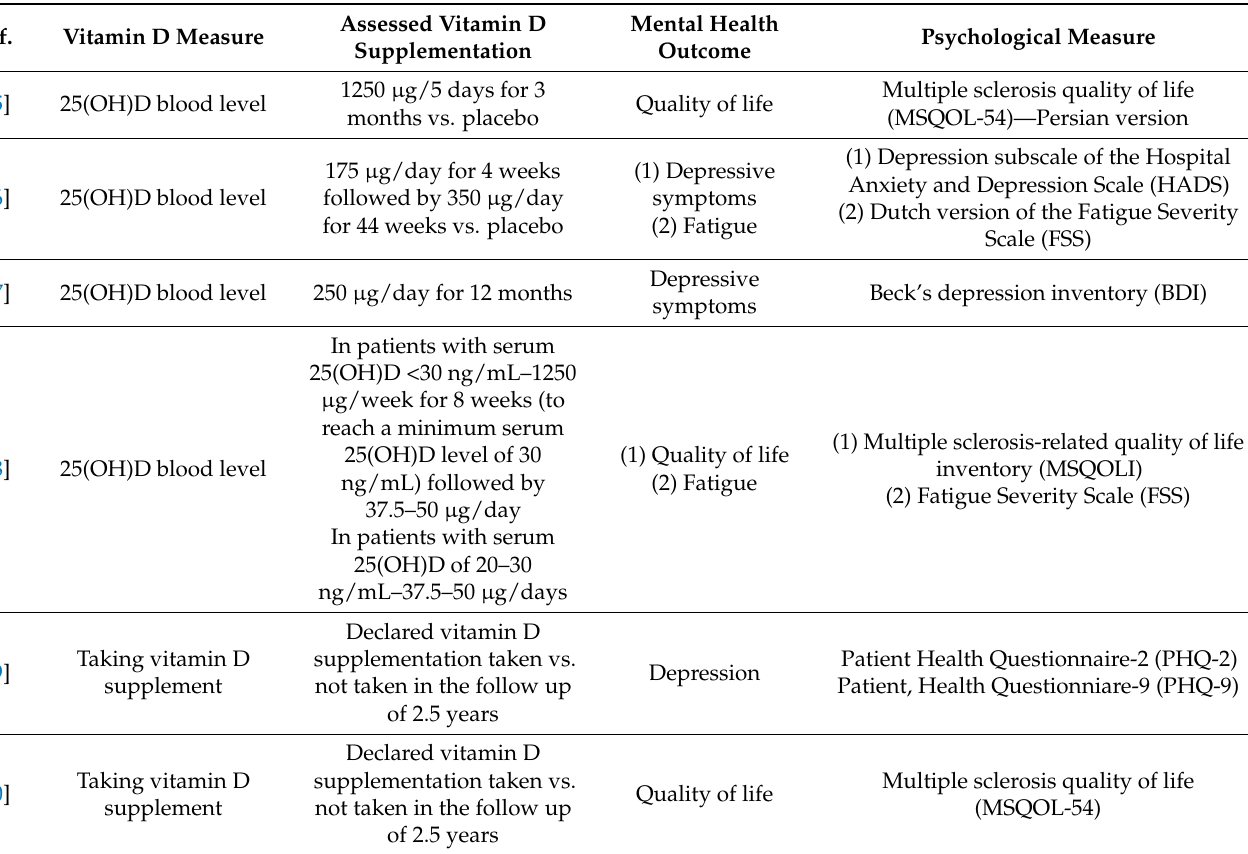
Table 4. The description of the vitamin D exposures applied within the studies and mental health outcomes assessed within the studies of multiple sclerosis (MS) patients included to the systematic review. Ref.